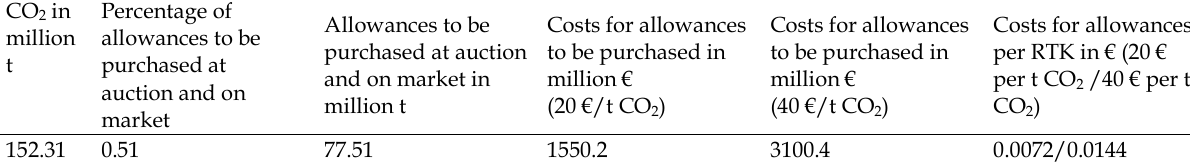
Table 8. CO 2 emissions and associated costs for airlines under the EU ETS according